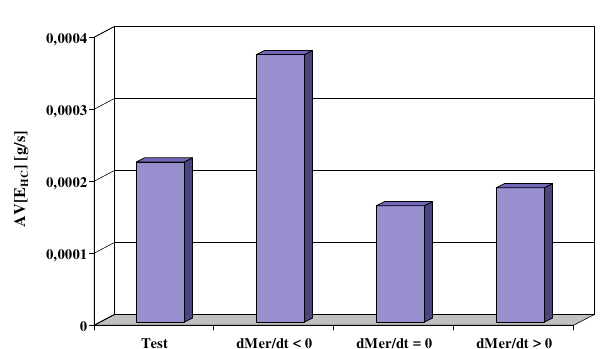
Fig. 17. The average value of the hydrocarbons emission in the NEDC test and in the states corresponding to the negative, zero and positive time derivative values of the engine speed